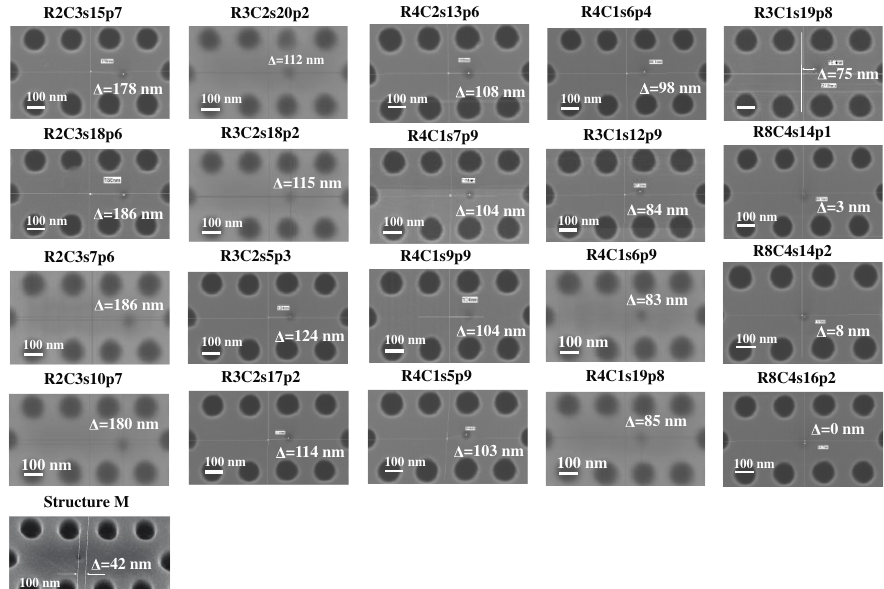
FIG. 10. Determination of the QD-PC cavity alignment accuracy using SEM. SEM images of GaAs = InGaAs pyramidal QDs with prescribed positions in a modified L 3 PC membrane cavity.